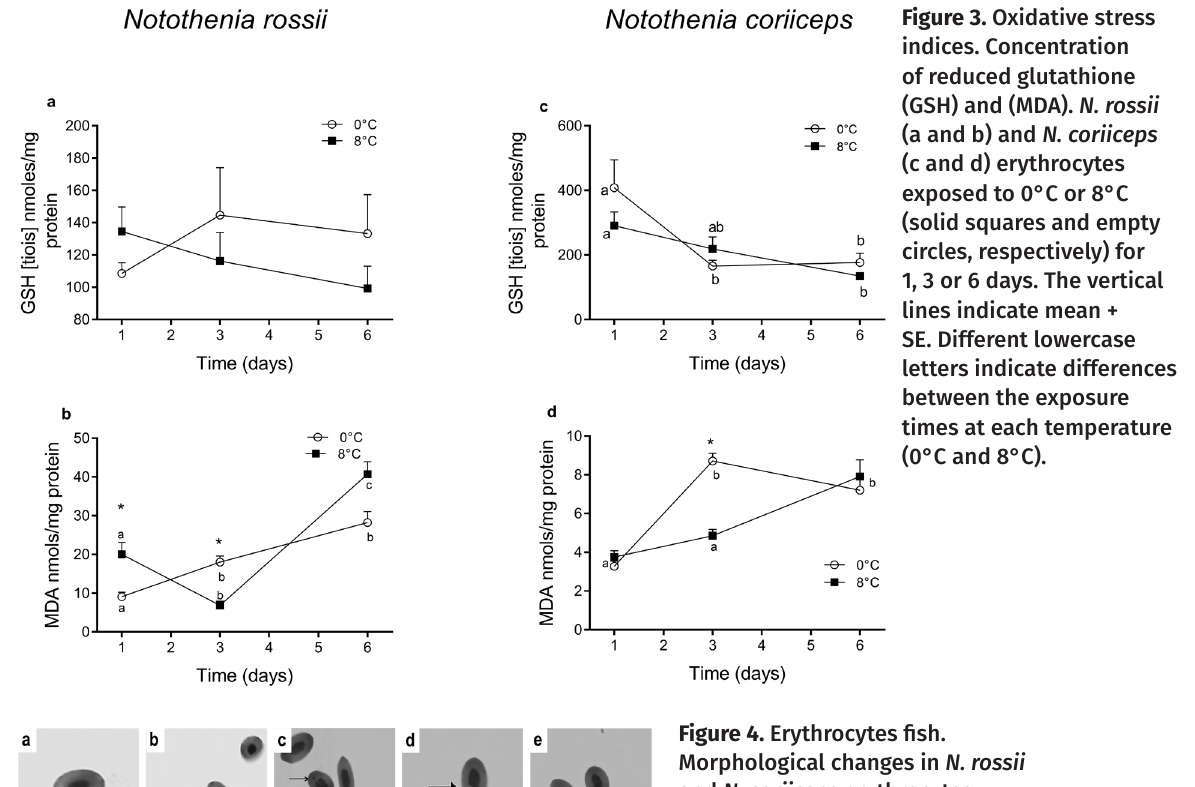
Figure 4. Erythrocytes fish. Morphological changes in N. rossii and N. coriiceps erythrocytes subjected to warming, optical microscopy (a-e) and electron microscopy (f-n). a and f: Erythrocytes with usual cellular and nuclear morphology. b, g and h: Erythrocytes with changes in cell morphology (*). c: Erythrocytes with micronuclei ( → ) d: Erythrocytes with blebbed nuclei (è). b, i, j and k: Protrusions or vesicles in